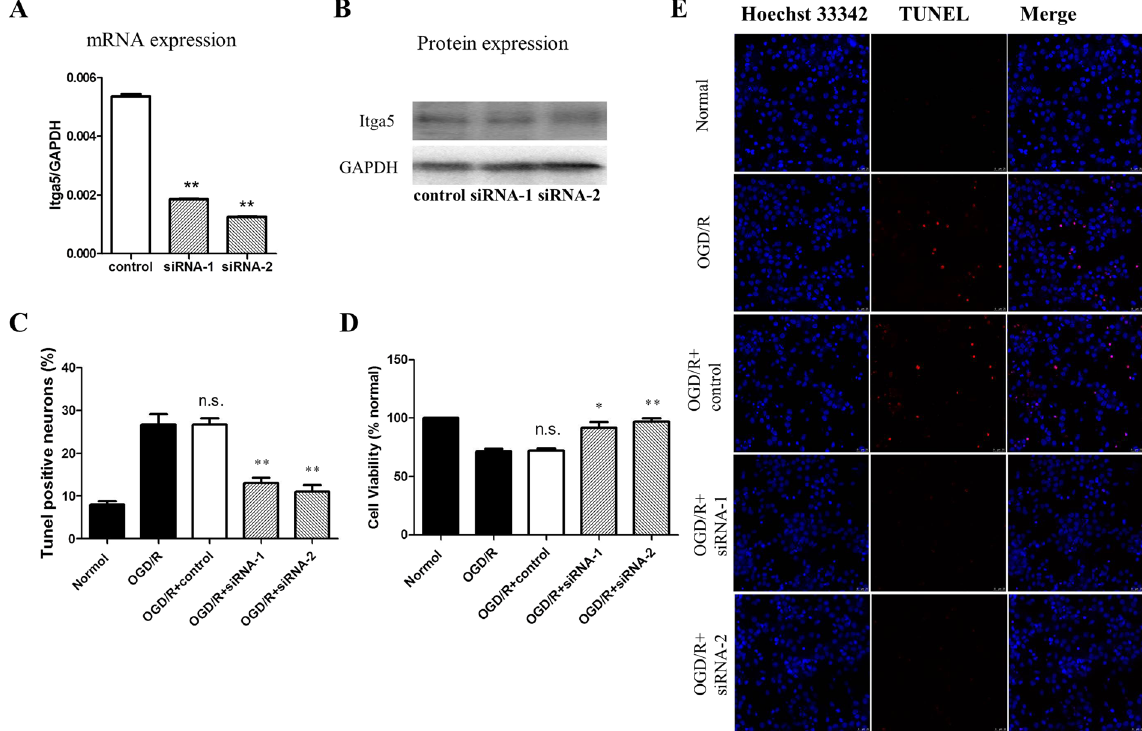
Figure 6. Itga5 downregulation promoted neuronal survival after OGD/R. ( A , B ) mRNA quantification ( A ) and Western blotting ( B ) of Itga5 expression under control, siRNA1 (against Itga5) treatment. ** p < 0.01, One-way ANOVA followed by Bonferroni post hoc correction, n = 3 for each condition (RNAs and proteins were pooled from 6 cultures for each condition). ( C , D ) Percentage of neuronal apoptosis (TUNEL staining, ( C ) and cell viability ( D ) in normal, OGD/R, OGD/R with control, siRNA1 & 2 (against Itga5) conditions. ** p < 0.01, One- way ANOVA followed by Bonferroni post hoc correction (against OGD/R condition), n = 6 for each condition. ( E ) Representative images of the staining of Hoechst 33342, TUNEL, and their merge in normal, OGD/R, OGD/R with control, siRNA1 & 2 (against Itga5)